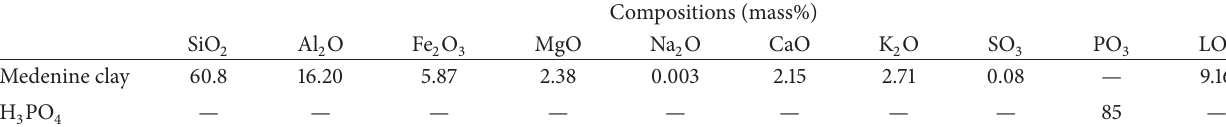
Table 1: Chemical composition of used materials.